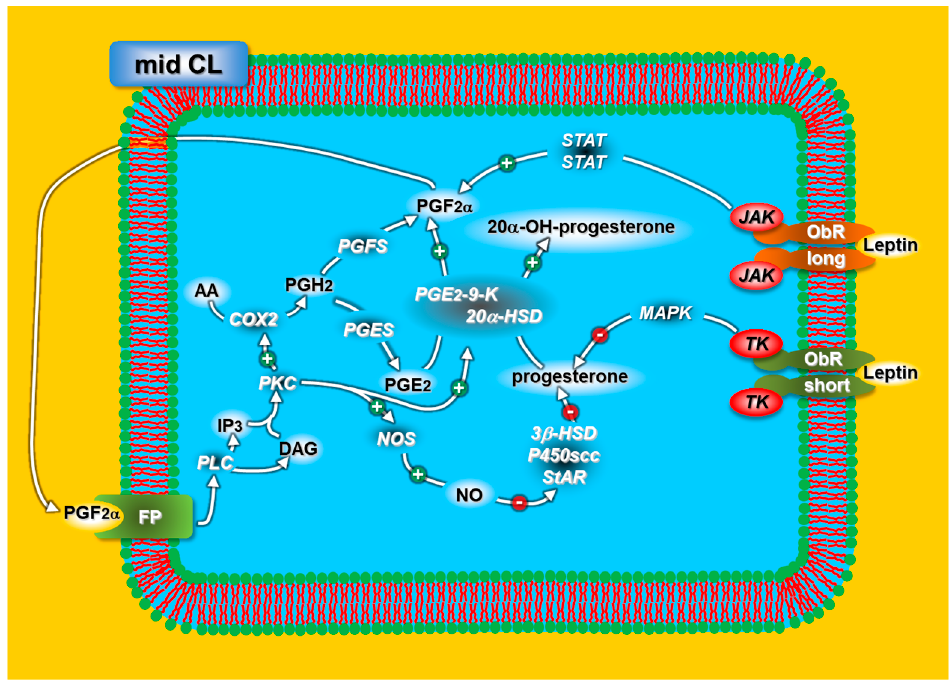
Figure 2. Schematic representation of the leptin mechanisms regulating progesterone release in rabbit mid-CL. For acronyms, see the list of abbreviations in the text.